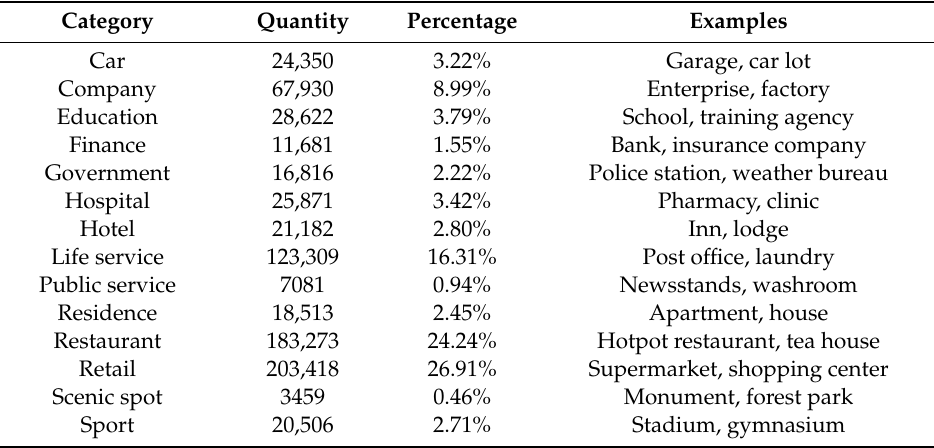
Table 3. Main categories of points of interest (POIs) retrieved for central